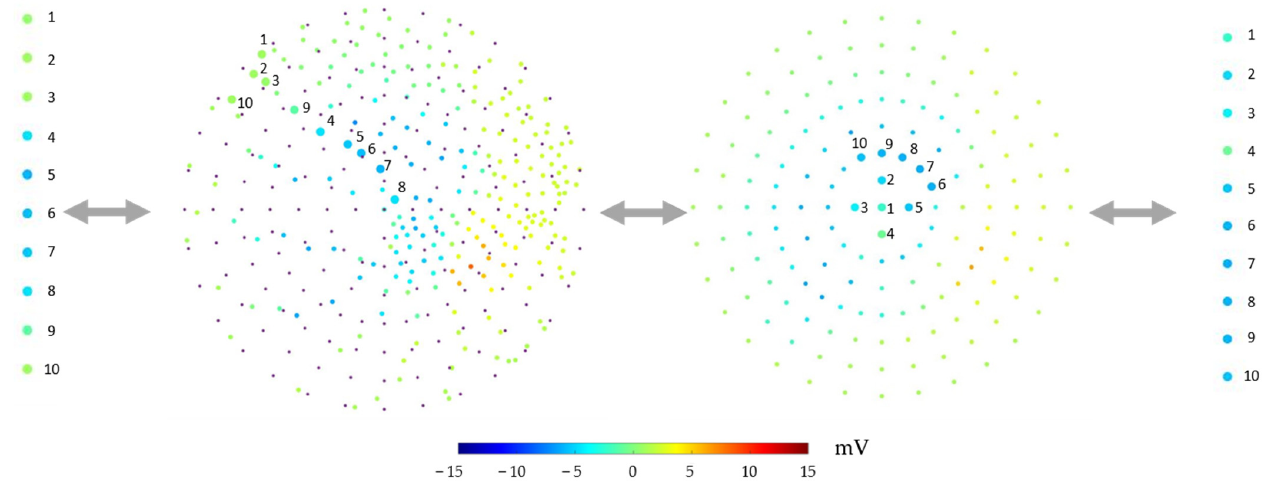
Figure 8. Transformation of 1D data by resampling with the new registration. Far left: First 10 nodes of the original potential data sequence 90 ms after the start of pacing. Middle left: Scatter plot of all epicardial nodes after the new registration. The larger nodes are 10 examples. The small purple nodes are the sampling locations of the template. Middle right: Results from sampling at the locations on the template. The bigger nodes are the first 10 nodes of the template. Far right: The first 10 nodes of the potential data after transformation. The potential values shown here are data from Pig 1’s first recording at 90 ms after the start of